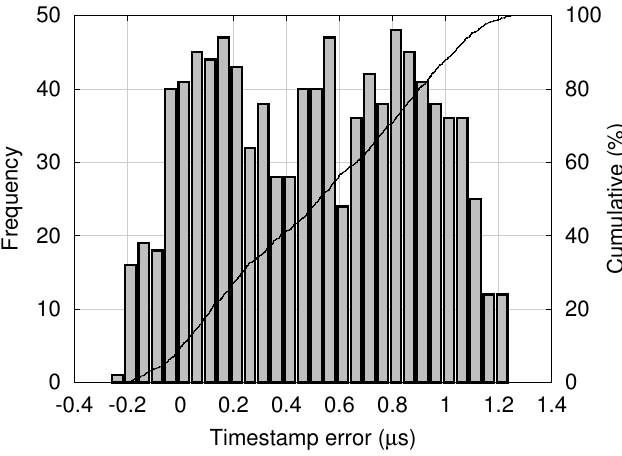
Figure 10. Distribution of timestamp error between the master and the